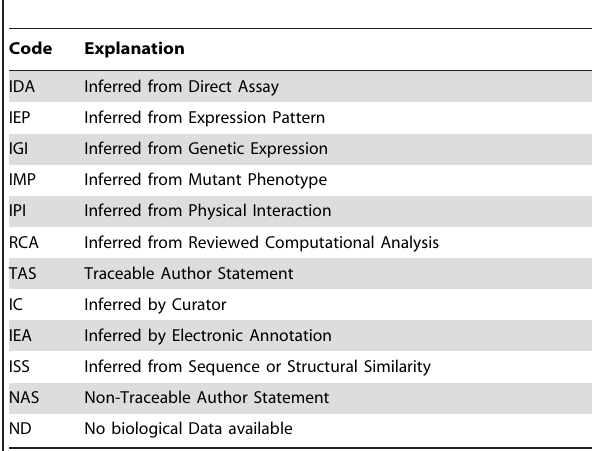
Table 1. Evidence codes used by the GOA Project.